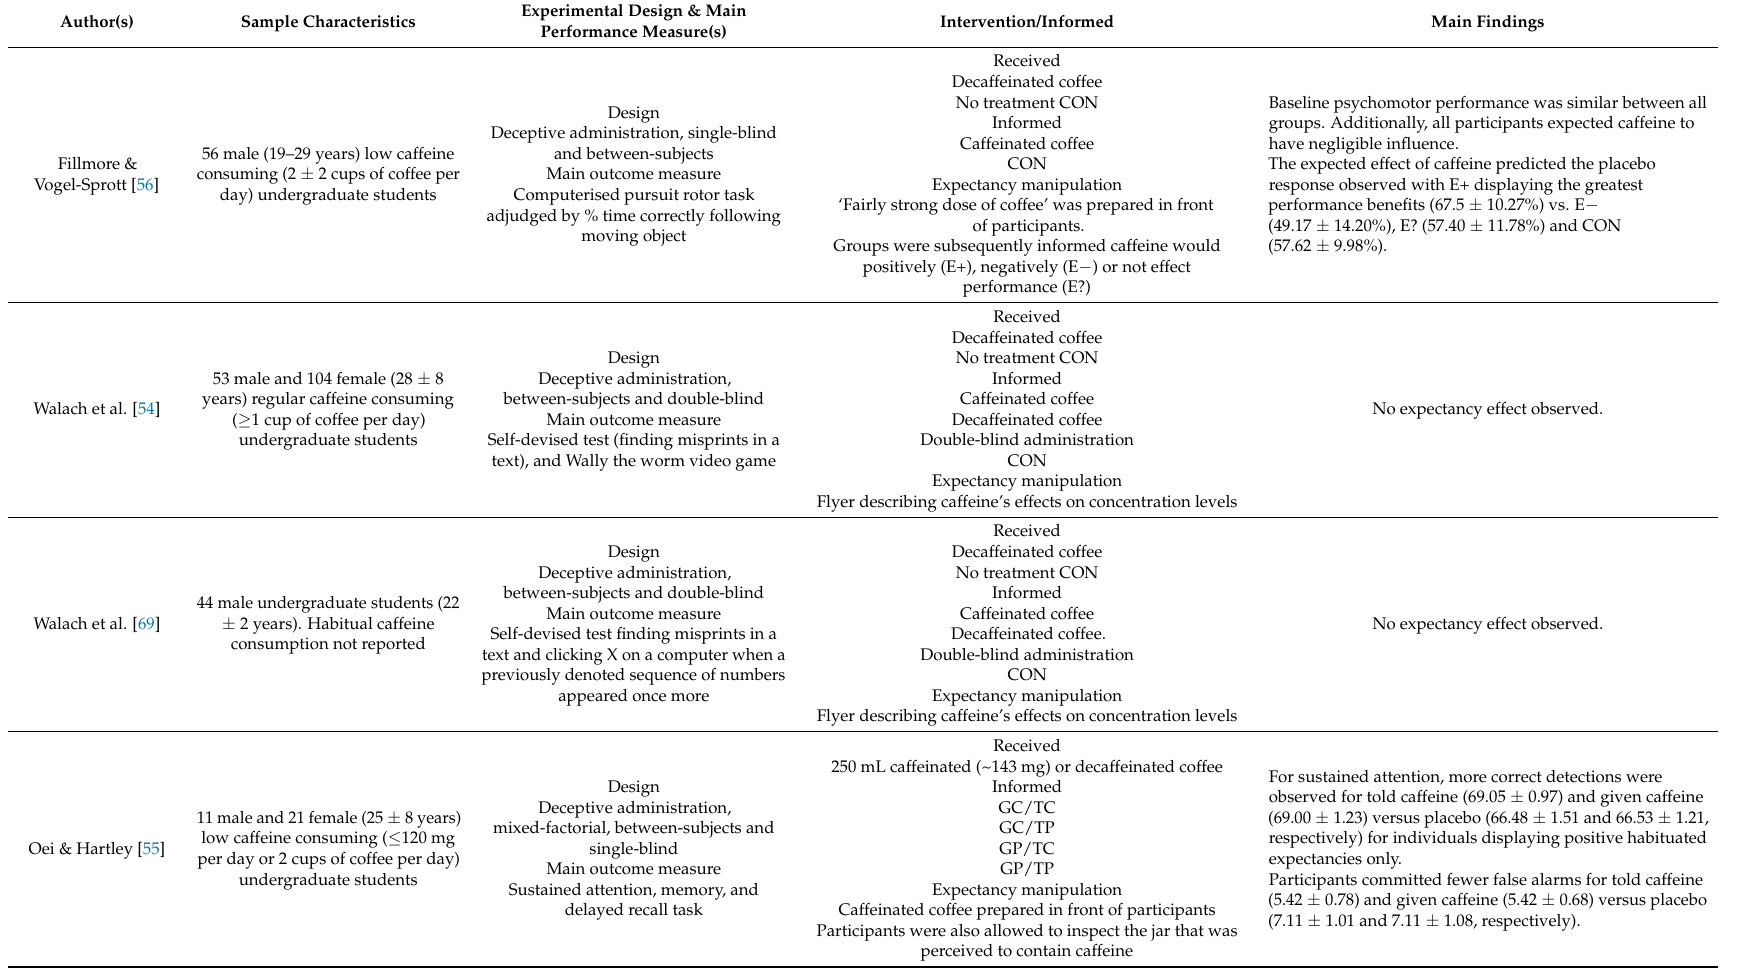
Table 2. Characteristics and findings of studies assessing caffeine expectancies on cognitive